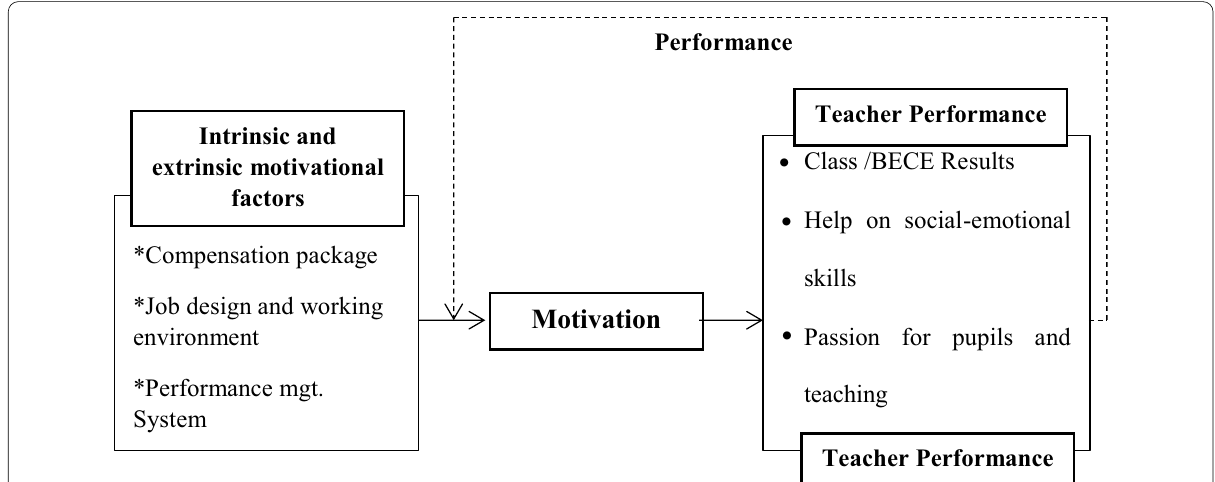
Fig. 1 A Conceptual model of the relationship between Motivation and Teachers’ Performance. Source : Created by the